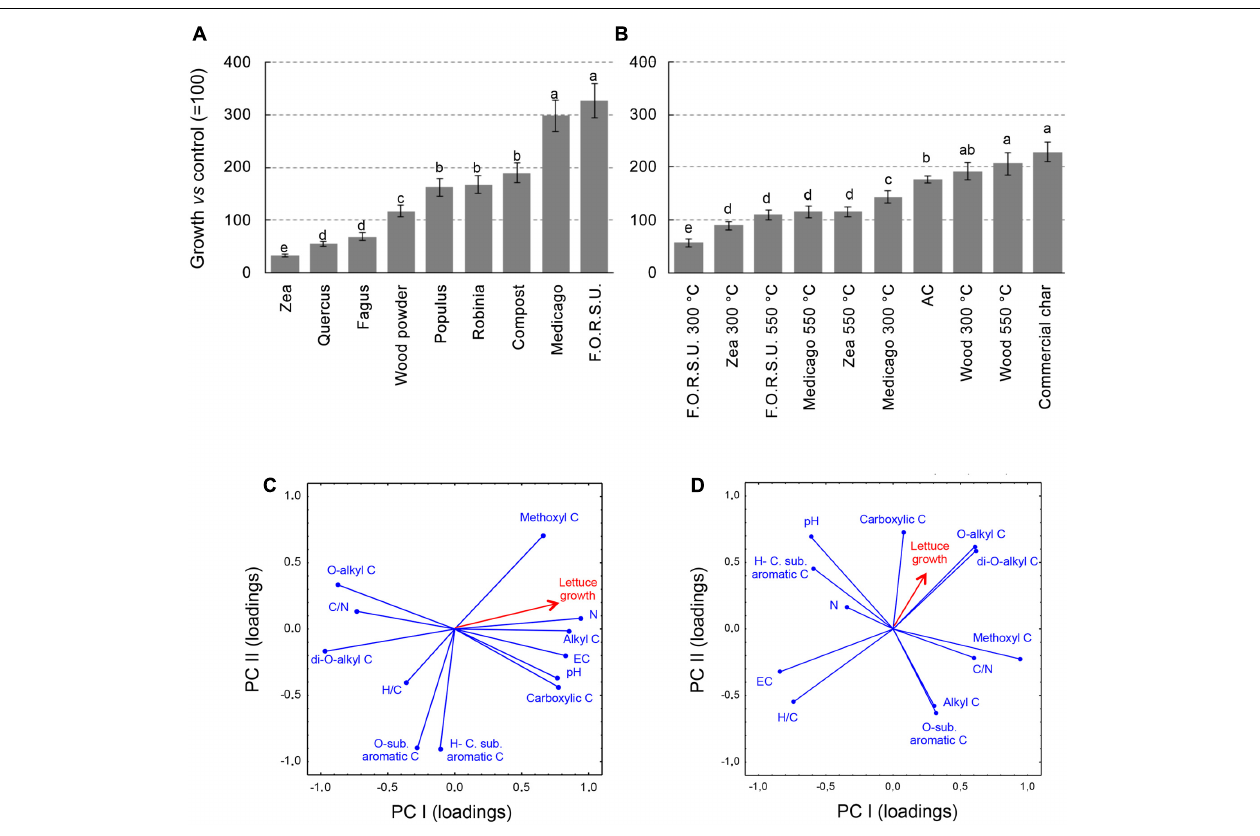
FIGURE 2 | Growth of lettuce ( Lactuca sativa ) plants in pot amended with not pyrogenic organic amendment (A) and biochar (B) at 2% (w/w). Values are expressed as percentage of untreated controls (=100%). Different letters indicate significant difference with comparison within each organic amendment type (Duncan test at P < 0.05). Principal component analysis (PCA) between not pyrogenic organic amendment (C) and biochar (D) , based on basic chemical parameters and seven 13 C NMR spectral regions with lettuce growth. Panel also shows target lettuce growth as supplementary variables following Legendre and Legendre